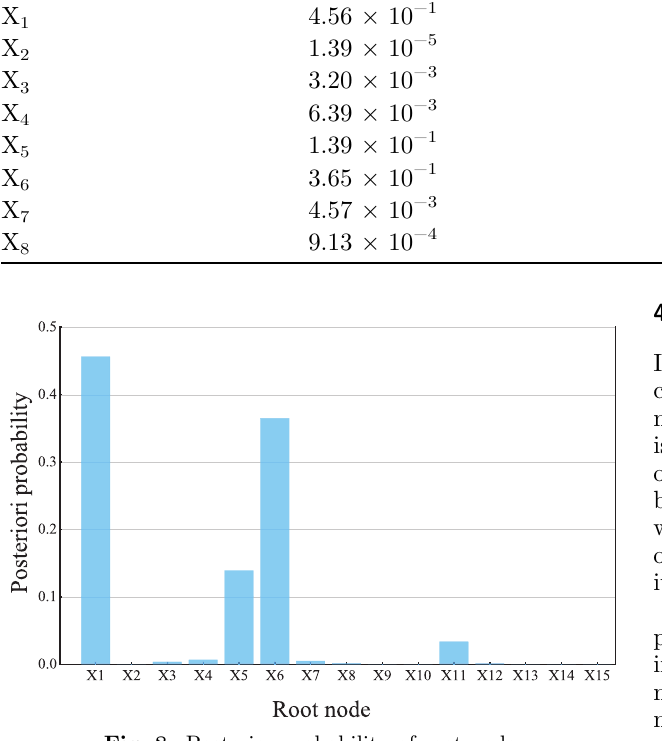
Fig. 8. Posterior probability of root